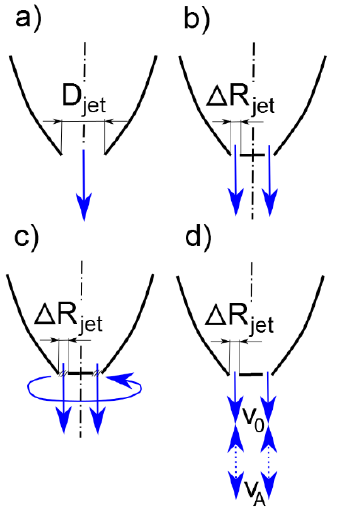
Fig. 11. Different types of water injection: a)full circular injection (Susan-Resiga [3, 4]), b) annular injection, c) annular injection with opposite swirl, d) annular injection with pulsating jet